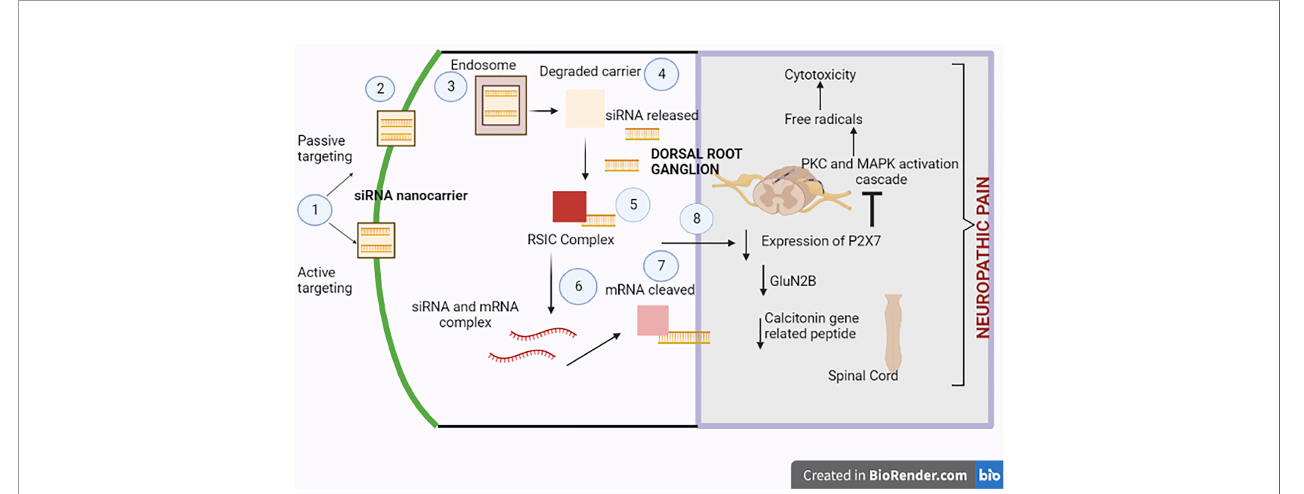
FIGURE 3 | Neuropathic pain-relieving molecular mechanism of siRNA-based nanocarriers. 1) Either passive or active targeting allows the siRNA delivery device to penetrate the cell. The attachment of antibodies or aptamers, which improve the device ’ s speci fi city, aids in active targeting. 2) The siRNA nanocarrier then enters the cell. 3) There is the engulfment of the delivery device by the endosome. 4) As a result, the outer carrier breaks down, releasing free siRNA therapeutics. 5) An RNA-induced silencing complex (RISC) is formed due to the siRNA formation. 6) To progress the knockdown of the chosen mRNA, the mRNA and siRNA interact with one another. 7) The RISC cleaves the mRNA to silence proteins implicated in neuropathic pain disease. 8) P2X7 receptor expression in the dorsal root ganglion, GluN2B peptide, and the calcitonin gene-related peptide in the spinal cord are suppressed. The siRNA delivery device reduces neuropathic pain by inhibiting excitation transmission through the P2X3 receptor in the DRG and inhibiting expressed calcitonin gene-related peptide in the spinal cord, which changes the calcium-augmented pathways in neuropathic